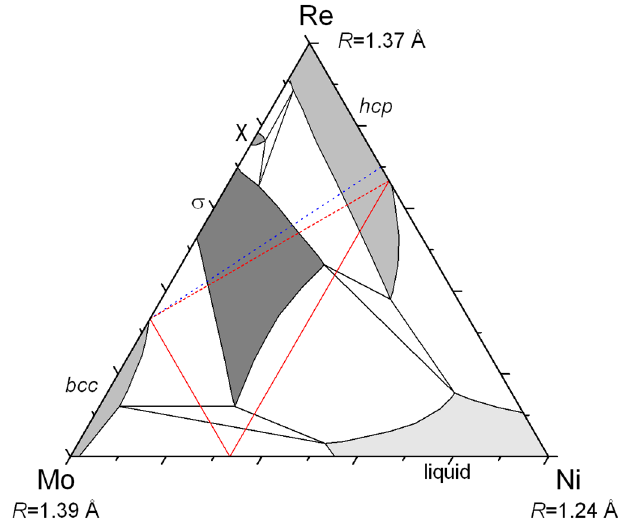
Figure 12. Isothermal section at 1600 °C of the Mo–Re–Ni system (redrawn from [25], Copyright 2013, Elsevier Science). The red triangle shows the three ordered stable or metastable compositions of the σ phase, Mo 2 Re, Mo 2 Ni, and Re 2 Ni, as in Figure 2 (solid line: normal substitution, dashed line: site reversal). The site occupancies of Figure 13 are calculated along the blue line.